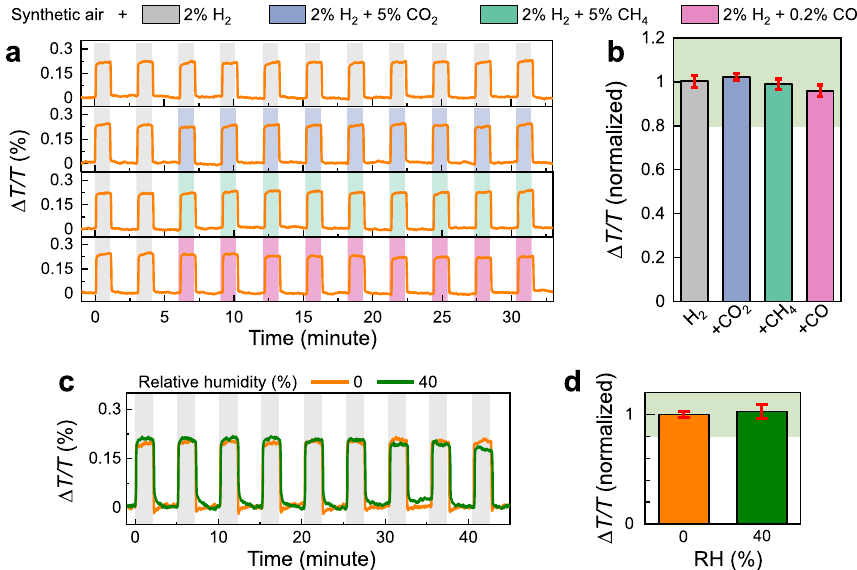
/PMMA to 2 pulses of 2% H 2 5 /PMMA to 9 pulses of 5